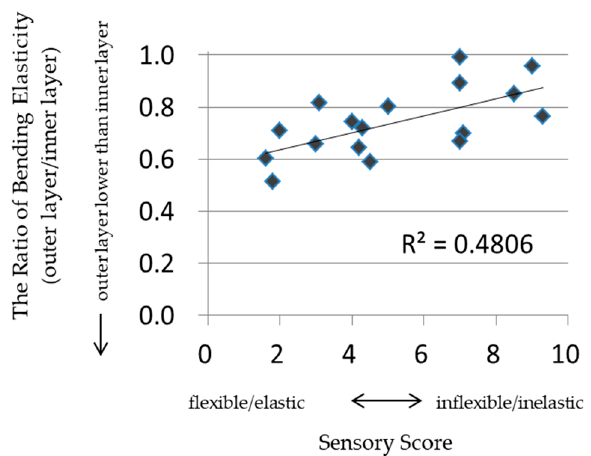
Figure 12. Relationship between the ratio of bending elasticity (outer layer/inner layer) and the sensory score. R 2 = coefficient of determination derived from regression line by least squares method.